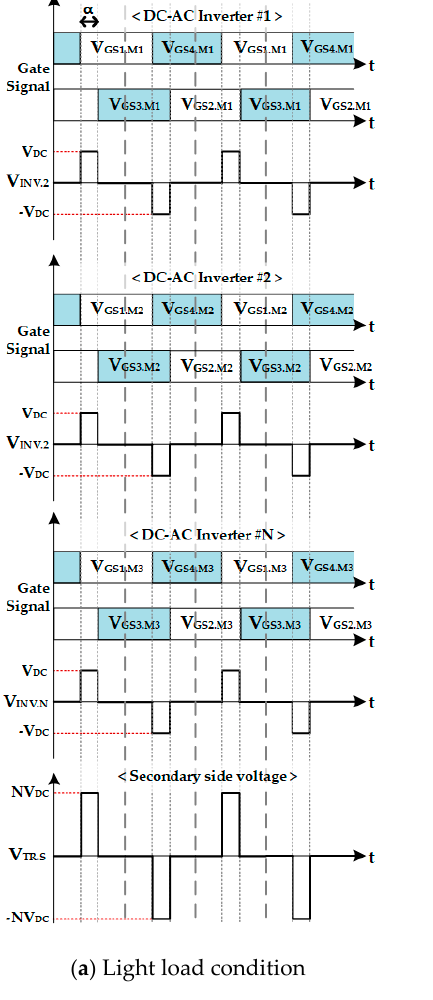
Figure 2. Example waveforms of DC-AC inverters with the conventional control method.